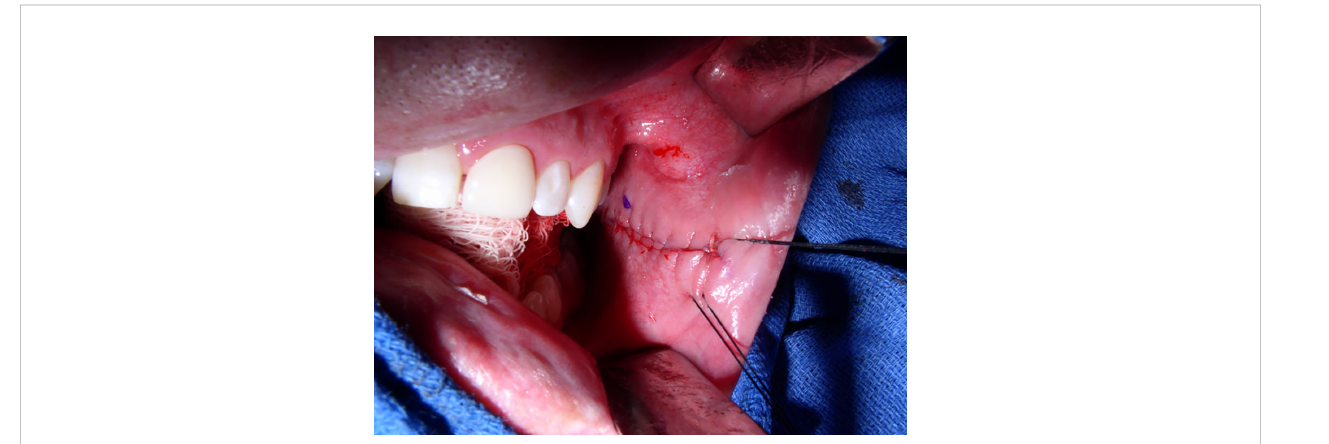
FIGURE 2 The BMG donor harvest site closed with an absorbable running suture. The blue dot indicates the Stensen ’ s duct. The image was obtained intraoperatively at Duke University Medical Center, with the operation completed under routine care. BMG, buccal mucosal